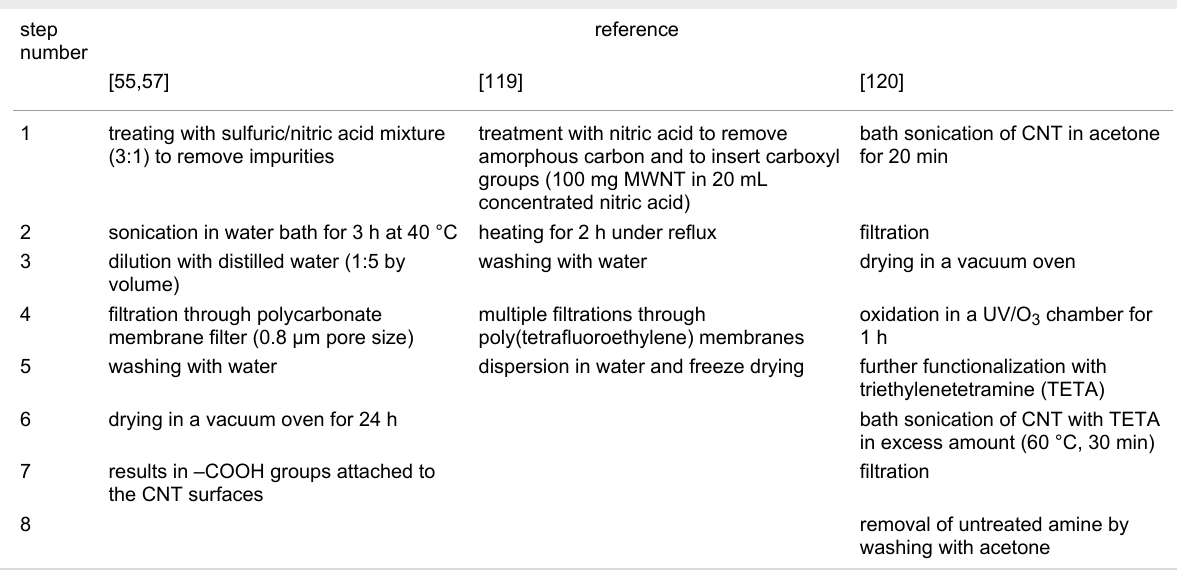
Table 3: Oxidation steps for